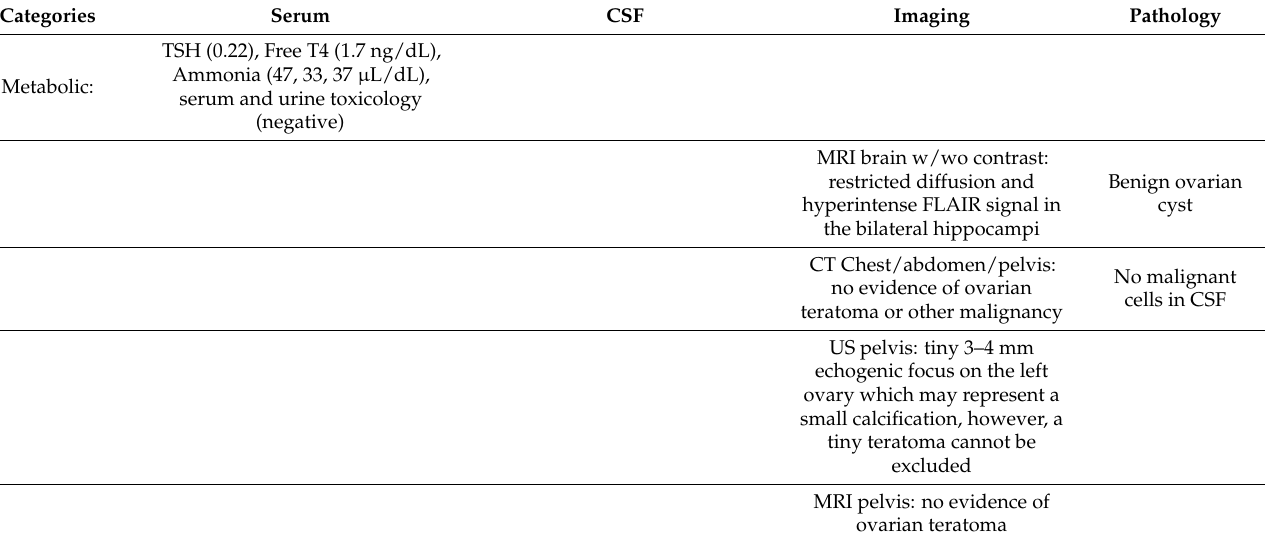
70: Scleroderma (antitopoisomerase)—negative; Antiribosomal P protein—negative; CRP: C-reactive protein—54 mg/L; ESR: erythro- cyte sedimentation rate—51 mm/h; C3/C4/CH50: within normal limits; B2 glycoprotein—negative; Anticardiolipin—negative; TPO: thyroperoxidase antibody—negative; thyroglobulin antibody—negative; ANCA: antineutrophil cytoplasmic antibody—negative; ACE: angiotensin converting enzyme—within normal limits; GAD 65: Glutamic acid decarboxylase—negative; NMDA: N-methyl-D-Aspartate receptor antibody—negative; AMPA: α -amino-3-hydroxy-5-methyl-4 -isoxazolepropionic acid receptor- antibody negative; TSH: thy- roid stimulating hormone—within normal limits; HIV: Human immunodeficiency virus—negative; Lyme disease—negative; West Nile Virus—negative; Enterovirus- negative; Bacterial and fungal culture—negative; HSV: Herpes Simplex Virus—negative; VZV: Varicella Zoster Virus—negative; HHV6: Human Herpes Virus 6—negative; EBV: Epstein Barr Virus—negative; GFAP: Glial Fibrillary Acidic Protein—negative; LGI1: Leucine-rich glioma-inactivated—negative; CASPR2: Contactin-associated protein-like 2—negative; DPPX: dipeptidyl-peptidase-like protein 6—negative; GABA: gamma-aminobutyric acid—negative; mGlu1: metabotropic glutamate receptor 1—negative; CRMP-5: CV2/collapsin response mediator protein—negative; Voltage gated potassium